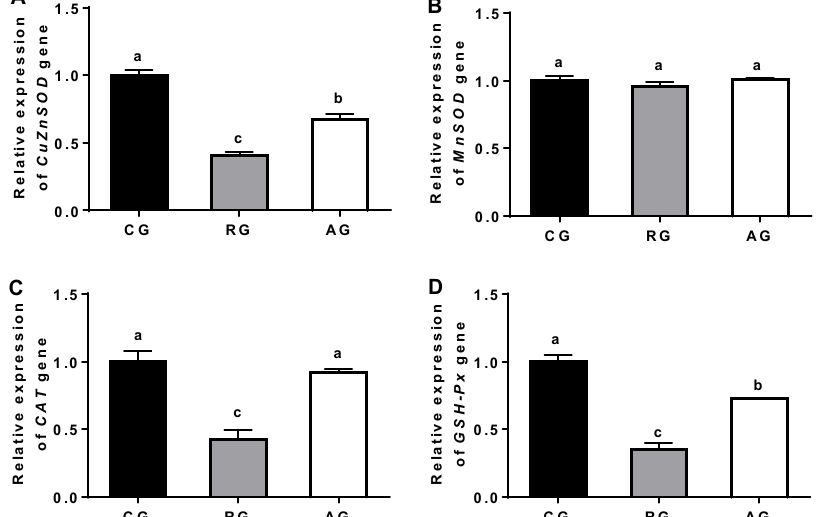
Figure 3. Effect of diet and arginine on antioxidant enzyme gene expressions in ovary of ewes. ( A ): Relative expression units of CuZnSOD gene; ( B ): Relative expression units of MnSOD gene; ( C ): Relative expression units of CAT gene; ( D ): Relative expression units of GSH-Px gene. Abbrevia- tions: CG, control group; RG, restriction group; AG, Arg group; CuZnSOD, copper-zinc superoxide dismutase; MnSOD, manganese superoxide dismutase; CAT, catalase; GSH-Px, glutathione peroxidase. Values are means ± SE (n = 6). Columns with different superscripts differ significantly among any groups ( p < 0.05). Table 5. Correlation coefficients (r) between antioxidant enzymatic activities and antioxidant en- zyme gene expressions and between Nrf2 gene expression and expressions of antioxidant enzyme gene or Keap1 gene in ovaries of ewes 1 .